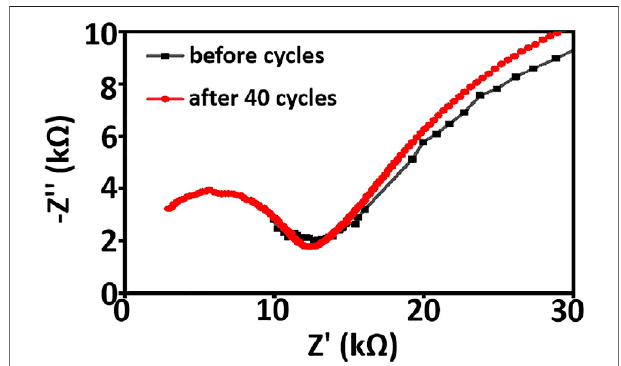
FIGURE 9 | (A) bottom-surface (B) top-surface SEM of the asymmetric organic-inorganic composite solid-state electrolyte after 40 cycles.